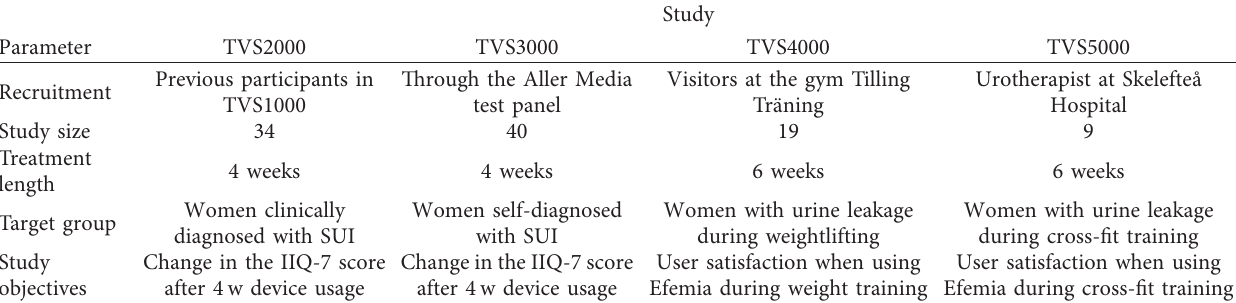
Table 1: Comparison of study design of the four postmarket surveillance